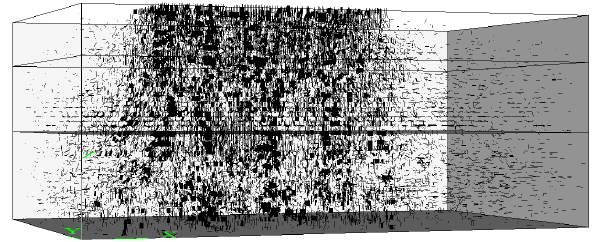
Figure 4. Distribution of the contact forces.